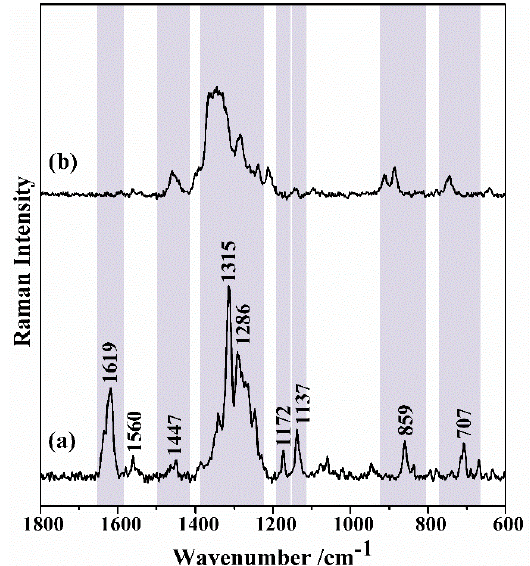
Figure 7. ( a ) Raman spectrum of tetracycline powder; ( b ) SERS spectrum of TC onto MNP-AuNS after contacting this sorbent with a solution of TC (10 µ M). Grey bars highlight Raman bands observed for both the TC powder and TC adsorbed onto MNP-AuNS. Table 1. Raman bands and respective assignments for the TC powder and TC adsorbed onto MNP- AuNS used as SERS substrates [24,25,27–29,55,66].